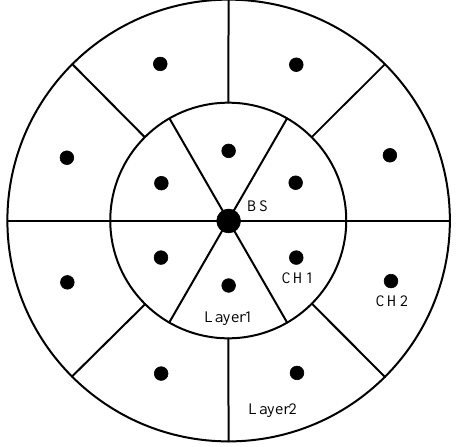
Figure 6. Pie Shaped Clusters Arranged in Two Layers in